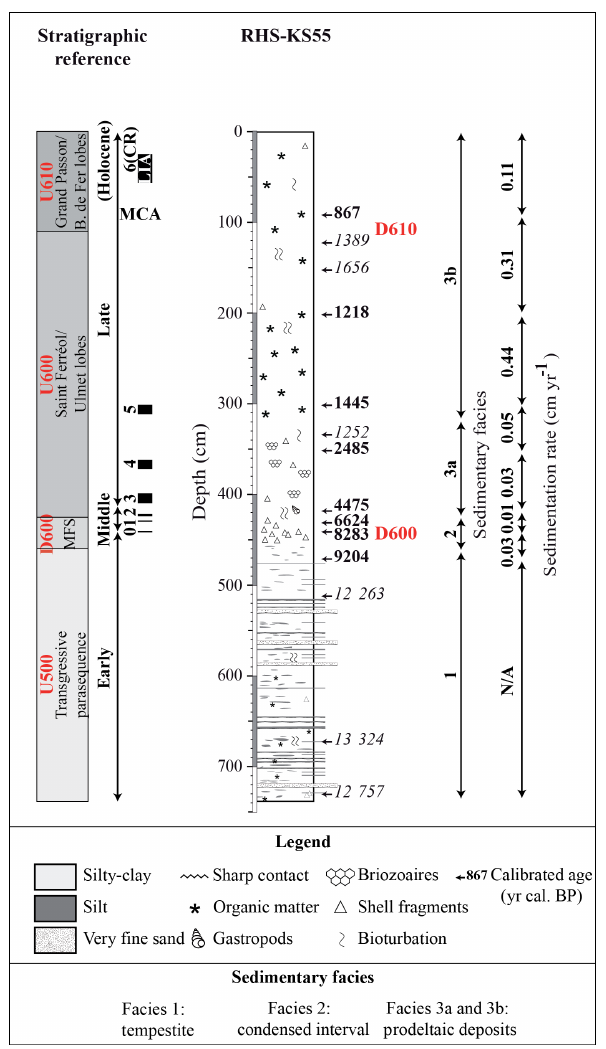
Figure 4. Sediment features and sedimentation rates of core RHS- KS55. Correlations with seismic units and discontinuities and with the Holocene chronology are shown on the left side of the figure. Black rectangles represent the most significant periods of climate deterioration (known as cold relapses (CRs); Wanner et al., 2014) during the Holocene (e.g., the 8.2ka event (CR0) and the Little Ice Age (CR6)). AMS 14 C dates are mentioned to the right; italic values correspond to age inversions. 14 C dates are summarized in Table